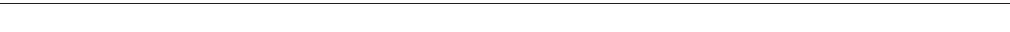
Fig. 2 SBA binding does not inhibit RSV binding or replication. a SBA-488 ( green ) was incubated with RSV A2 stocks for 30 min before fi laments were isolated onto glass coverslips. Isolated virions were fi xed and stained for RSV N ( red ) and RSV F ( blue ). Scale bar represents 2 µ m. b SBA-488 labeled virus ( green ) was used to inoculate Vero cells at an MOI of 1. At 24 hpi, cells were fi xed and immunostained for RSV N ( red ), RSV F ( blue ), and nuclei ( gray ). Scale bar represents 10 µ m. c RSV A2 was incubated with either SBA or vehicle control for 2 h at 37 °C. Virus was then used to inoculate Vero cells at an MOI of 1. At 12 or 24 hpi, cells were lysed, and lysates were assayed by western blotting for RSV G. β -actin is included as a loading control. Image is representative of two independent experiments. d Replicate lanes ( n = 2) were quanti fi ed by densitometry to compare the amount of RSV G signal from SBA-labeled or unlabeled RSV infections. There were no statistically signi fi cant differences at either time point (two-way ANOVA, p > 0.05). Error bars represent standard deviation. e rgRSV-GFP was incubated with the indicated concentrations of either palivizumab, SBA, or vehicle control for 2 h at 37 °C. Virus treatments and a mock treatment were then used to inoculate Vero cells at an MOI of 1. At 48 hpi cells were lifted into a single-cell suspension and analyzed by fl ow cytometry. Data represents the mean percentage of infected cells in three independent experiments. Error bars represent standard deviation. Asterisk indicates signi fi cant difference vs. mock infection (one-way ANOVA on ranks, p < 0.05). f Relative quantity of RSV N ( left ) and RSV G ( right ) expression via qRT-PCR upon infection of Vero cells with SBA-labeled or unlabeled RSV A2 at an MOI of 1 at 6, 12, and 24 hpi. There was no statistically signi fi cant difference at any time point (two-way ANOVA, p > 0.05). Error bars represent standard deviation. Results are the mean of two independent experiments normalized by the control virus at 24 hpi